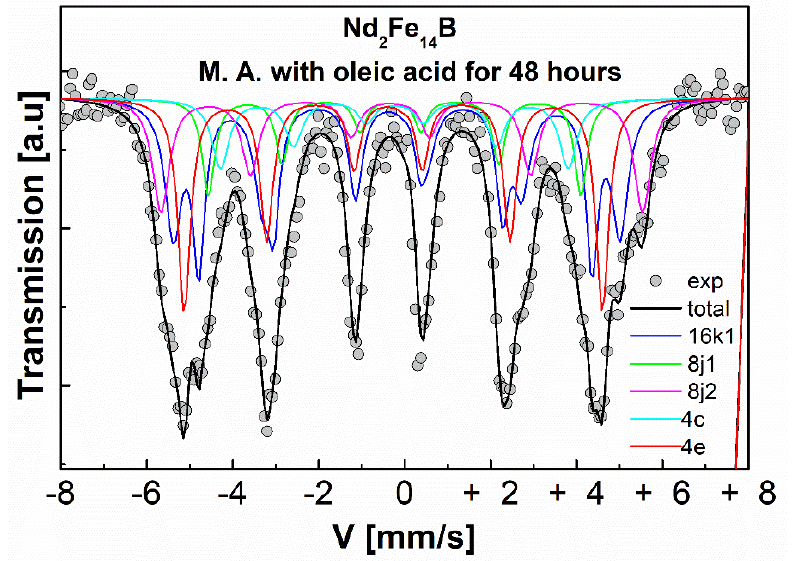
Figure 7. Mössbauer spectra of the Nd 2 Fe 14 B system mechanically alloyed (M.A.), with oleic acid for 48 h. Table 5. Mössbauer parameters of the commercial Nd 2 Fe 14 B system for 48 h of milling time with oleic acid as a surfactant. The column with (HF) corresponds to the hyperfine field; and the lines with (J1, J2, K1, K2, C, E) correspond to the non-equivalent crystallographic iron site for Nd 2 Fe 14